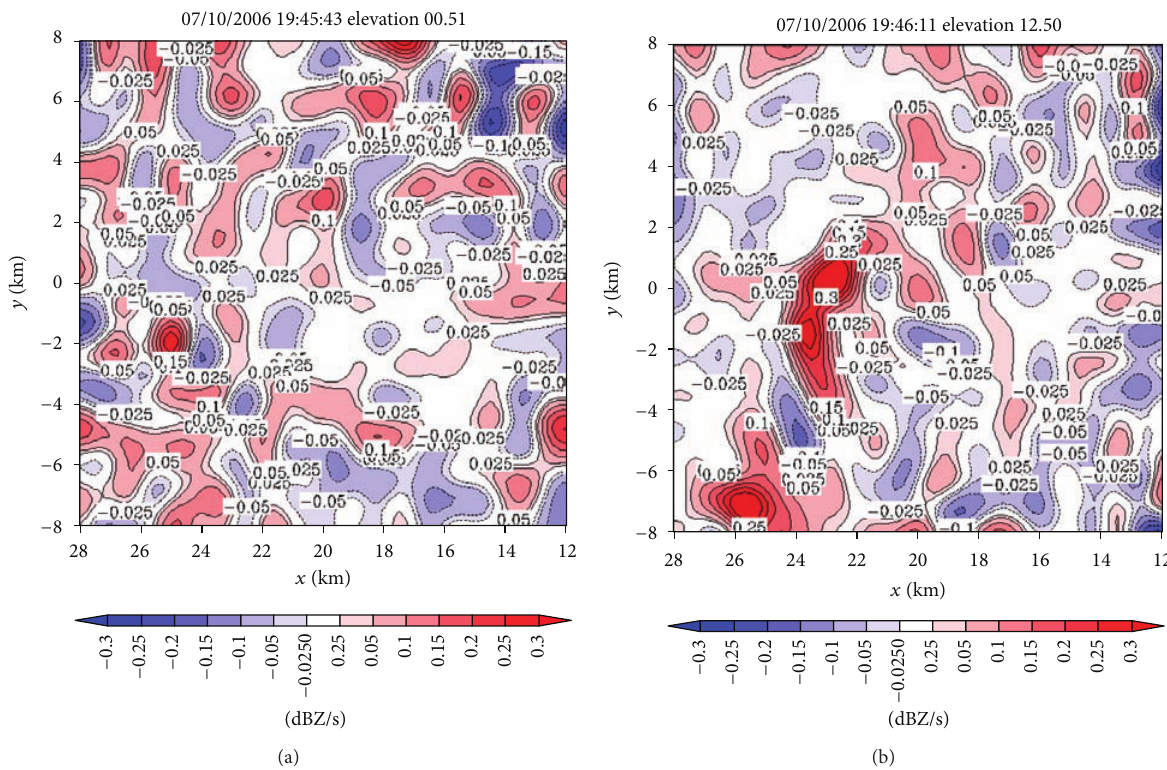
Figure 5: Reflectivity source fields (for the 𝑆 𝑚 term on the right hand-side of (3a)) produced as by-products of the retrievals in Figures 4(a) and 4(e) on the conical surfaces of (a) 𝜃 = 0.51 ∘ and (b) 𝜃 = 12.5 ∘ . The color scale is shown on the bottom of the figure, and the unit is dBZs −1 for the labeled contour